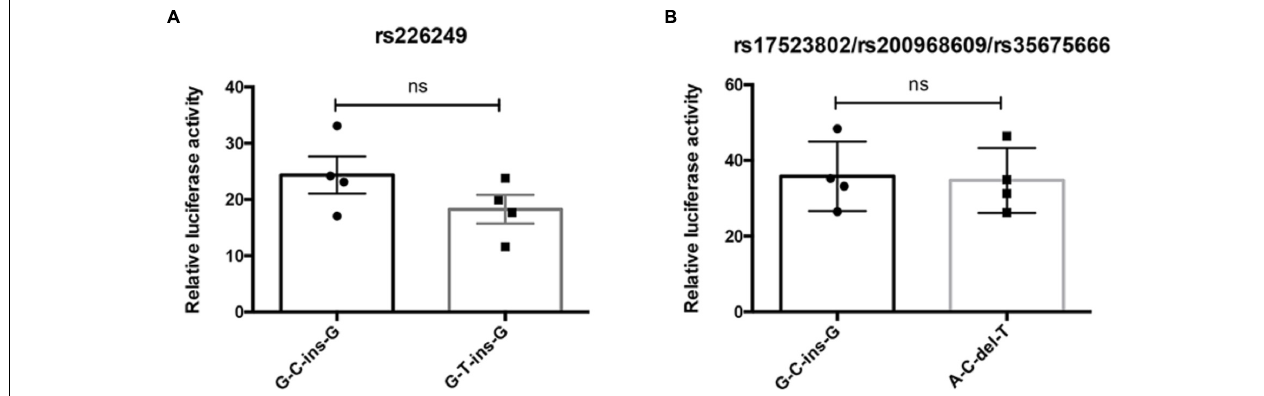
FIGURE 3 | The influence of promoter polymorphisms on DJ-1 promoter transcriptional activity. Dual-luciferase reporter assay was used to access whether rs226249 (A) or rs17523802/rs200968609/rs35675666 (B) affect DJ-1 promoter transcriptional activity. The haplotype alleles arrayed in order of rs17523802,